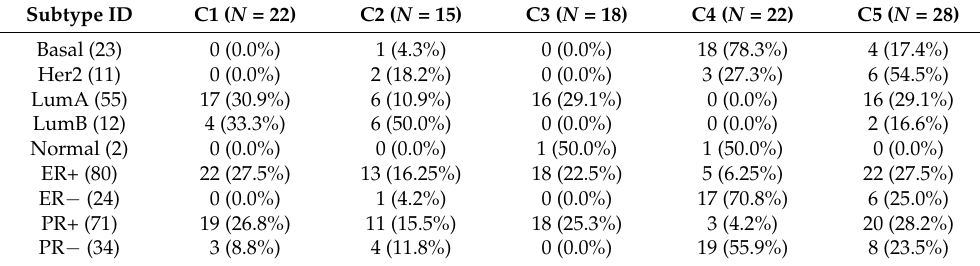
Table 5. The overlaps of the identified subtype clusters with PAM50 subtypes in BIC cancer